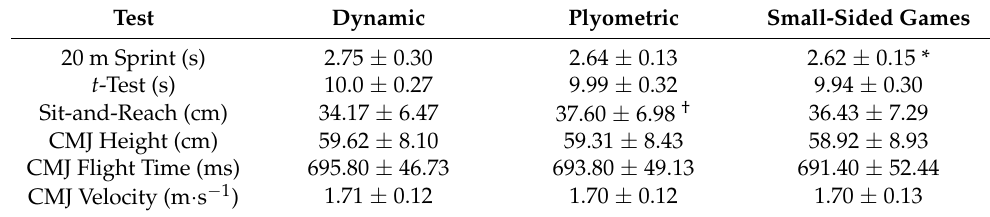
Table 3. Performance test results ( n =